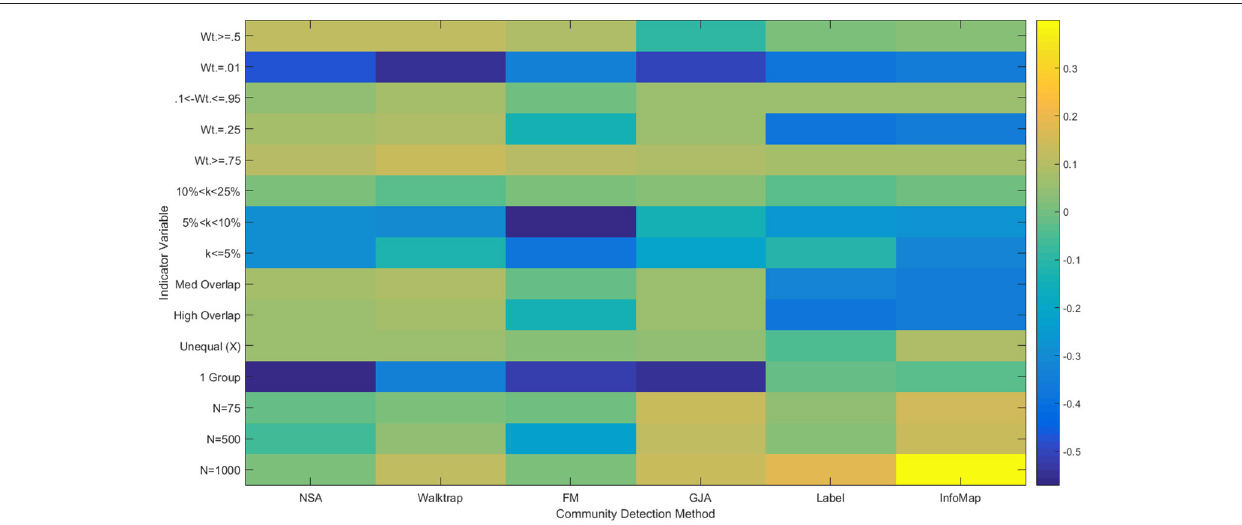
FIGURE 6 | Heatmap of multiple regression results for correlation matrices. Standardized betas are depicted from multiple regressions conducted for each method using the condition indicator variables to predict ARIHA. “Wt.” = indegree connectivity weight; “ k ” refers to the proportion of the sample in each community; “Med” = Medium; “Unequal” refers to unequal community sizes; “ N ” refers to graph size. Reference category is: N = 25, equally sized communities, low overlap, each community containing at least 25% of the sample, and indegree weight between 0.25 and 0.95.